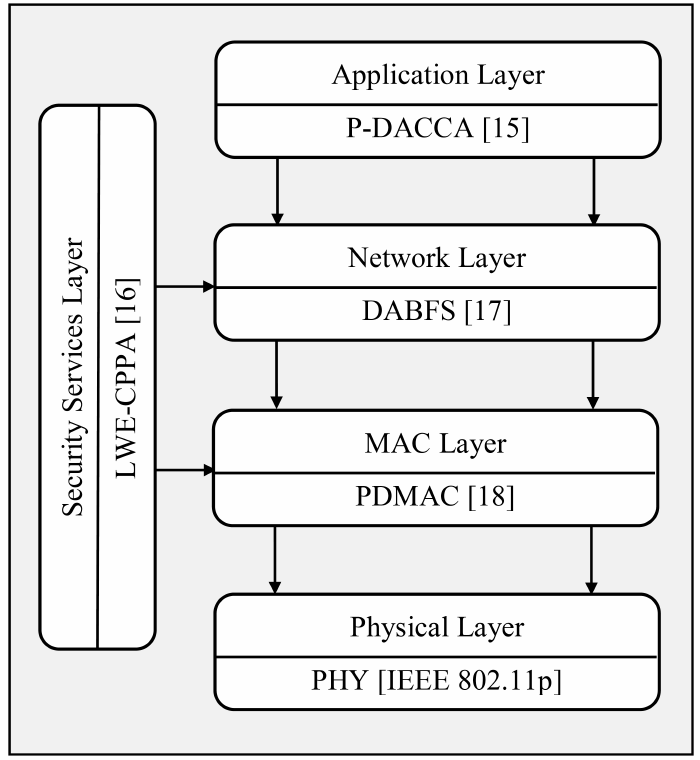
Figure 1. The proposed Direction-Aware Vehicular Collision Avoidance (DVCA)